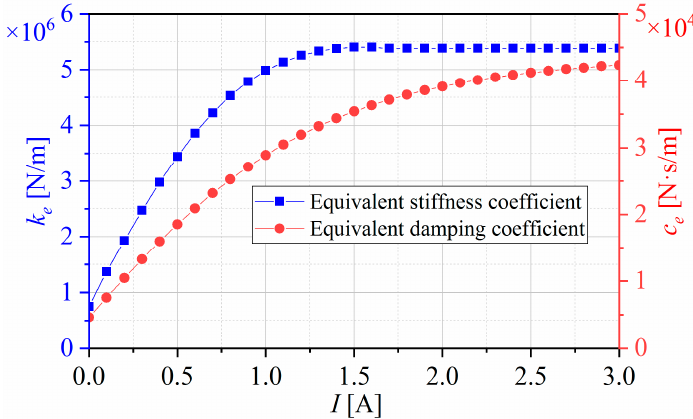
ff ness and damping coe ffi cients of MRD varied with the Figure 11. Equivalent stiffness and damping coefficients of MRD varied with the current. Figure 11. Equivalent sti